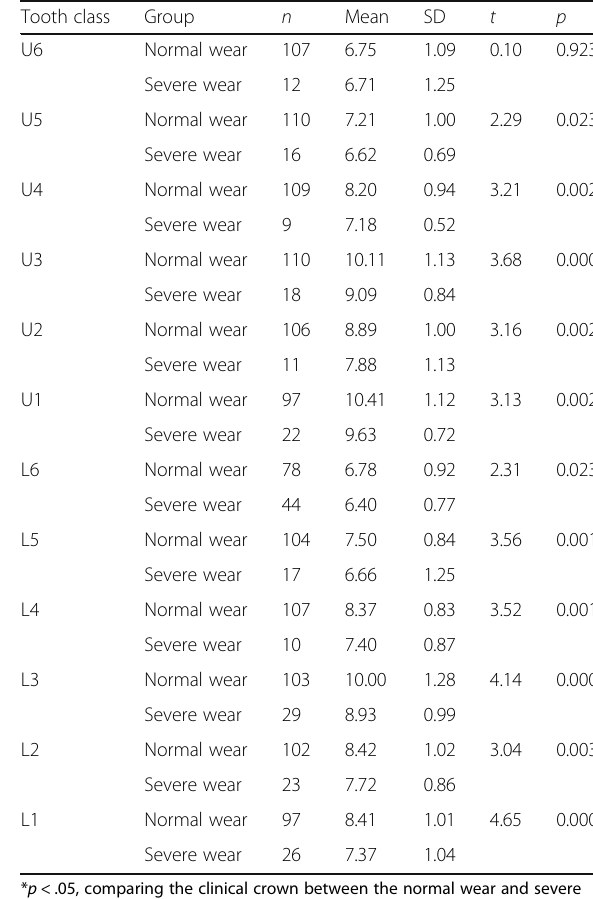
Table 6 Independent t -tests comparing the clinical crown height for the normal wear and severe wear subsets measured by the clinical crown height for the combined four